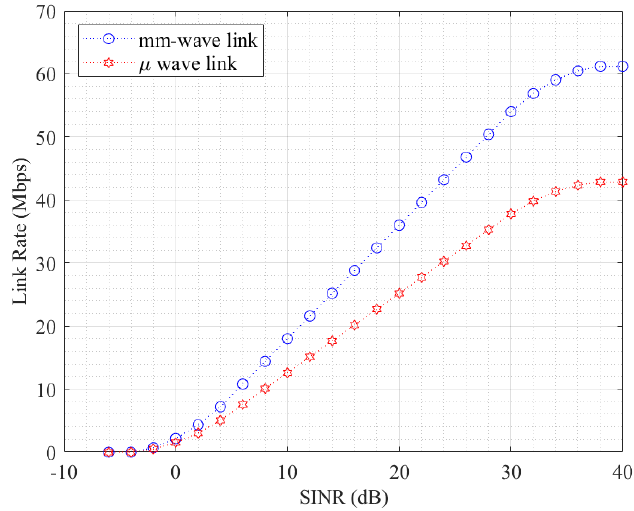
Figure 9. SINR vs Link Rate of mm-waves and µ waves.